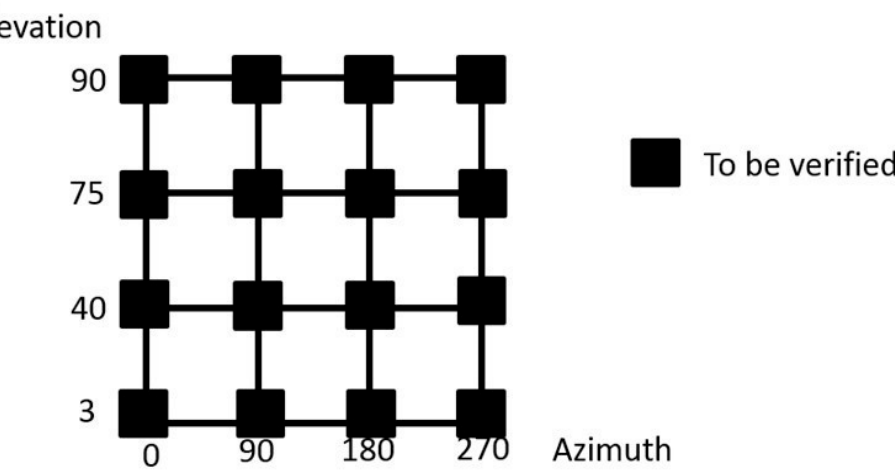
Figure 2. Mapping matrix for the RPE test.